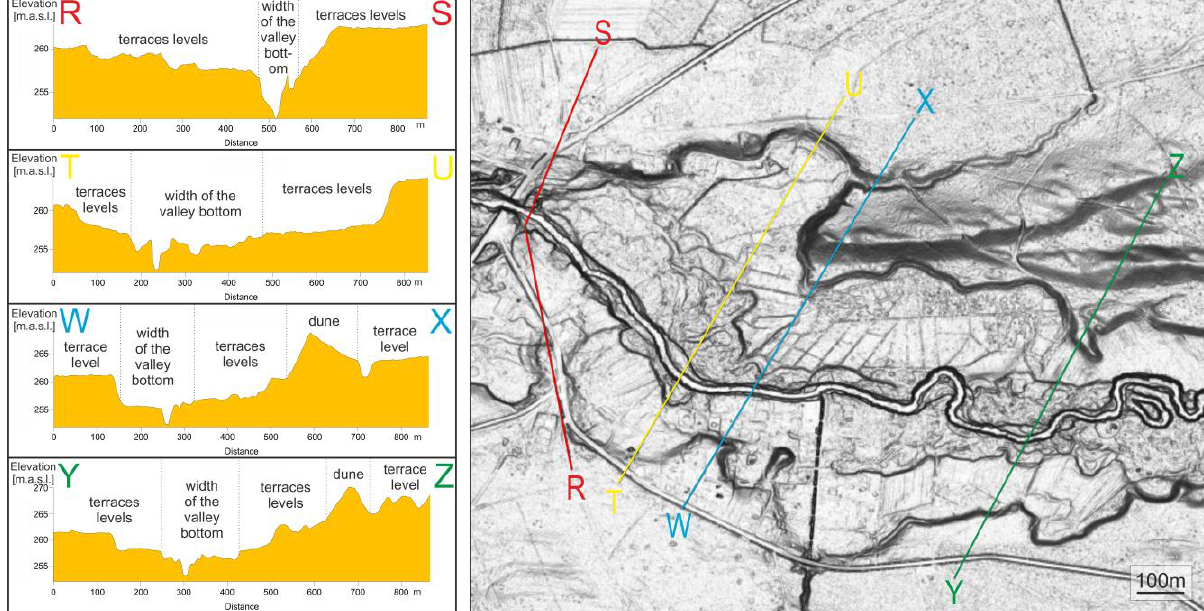
Fig. 7. Location of the former Brusiek ironworks on the shaded relief map with cross section lines representing relief valley